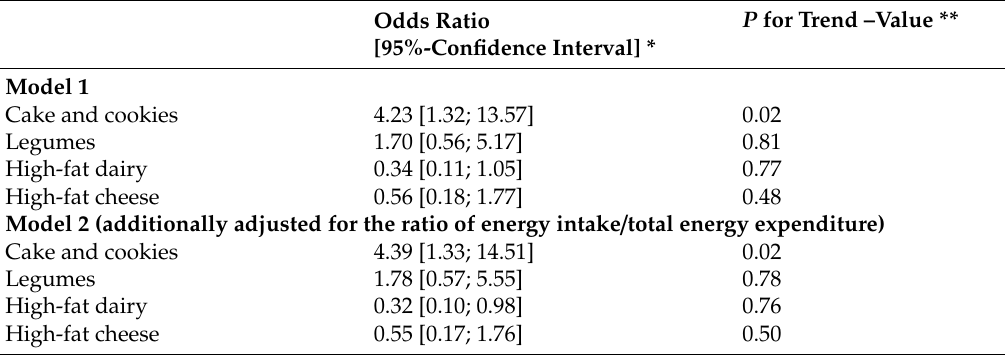
Table 5. Associations between food consumption and NAFLD ( n =